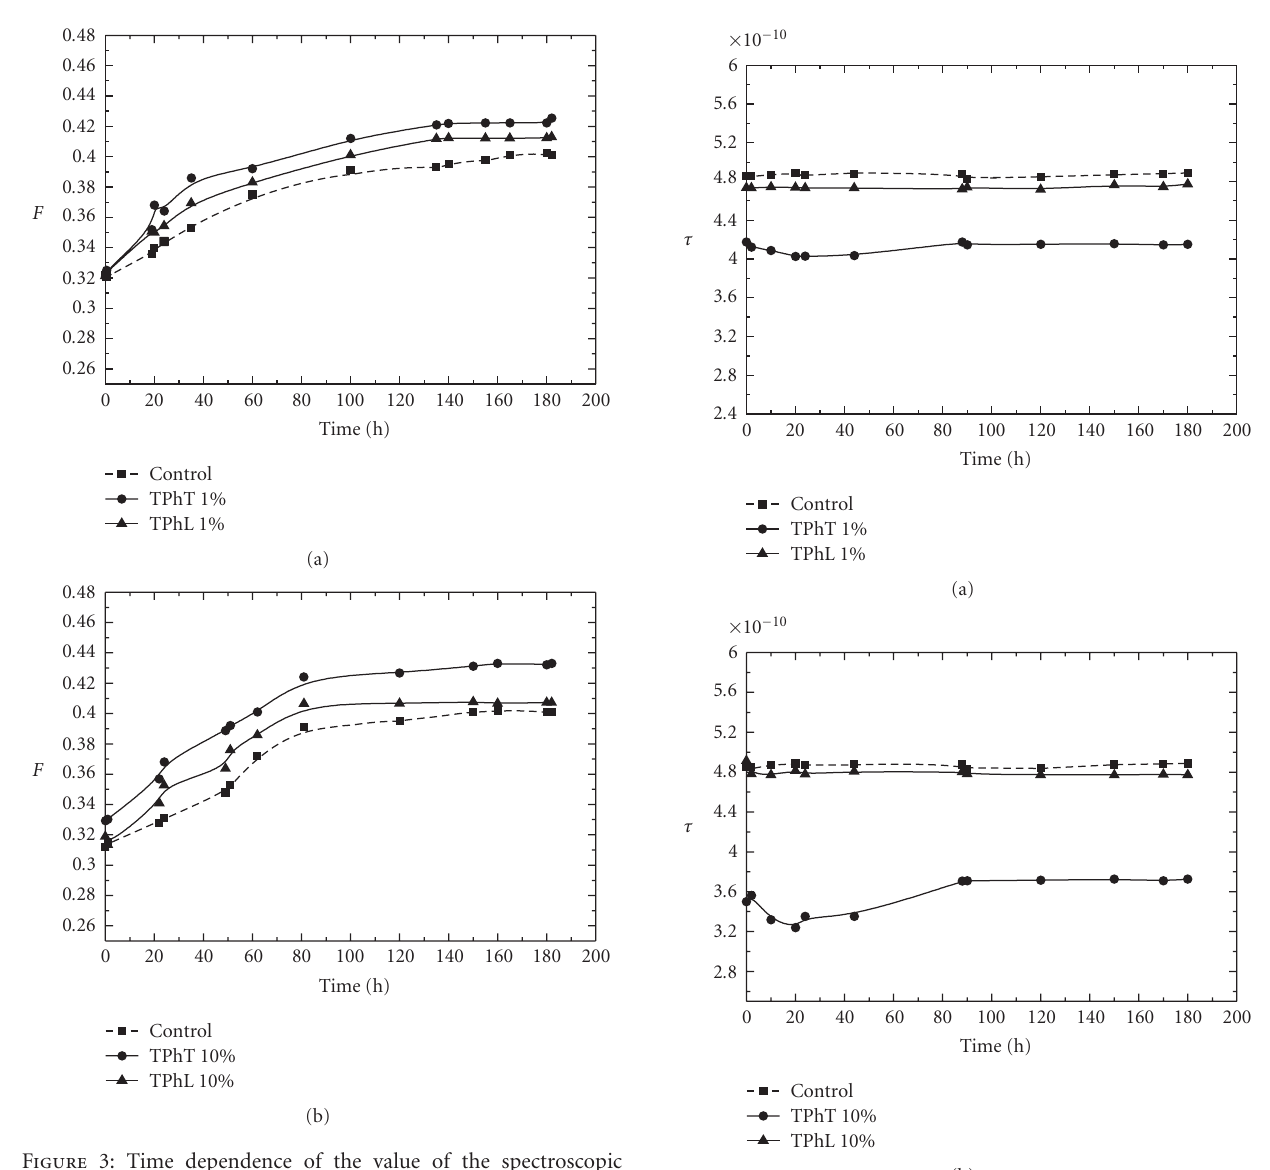
Figure 3: Time dependence of the value of the spectroscopic parameter F of the TEMPO probe, dissolved in water suspension of EYL liposomes containing admixtures of (a) 1% TPhT and TPhL; (b) 10% TPhT and TPhL. The dashed line on diagrams marks the value of parameter F for the control sample containing liposomes without a compound.